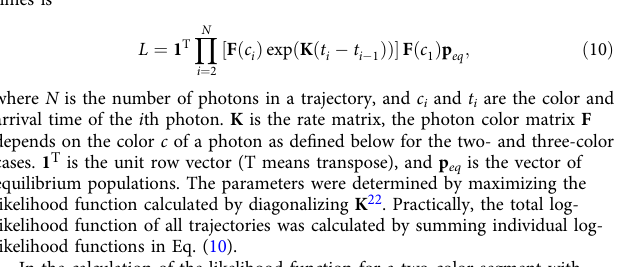
The fractions of acceptor photon count rates for the calculation of the FRET ef fi ciencies above are corrected for background photons, detector cross-talk, and direct excitation of A1 and A2 (see below). Maximum likelihood method in the absence of acceptor blinking . The like- lihood function for a photon trajectory with records of photon colors and arrival times is 22